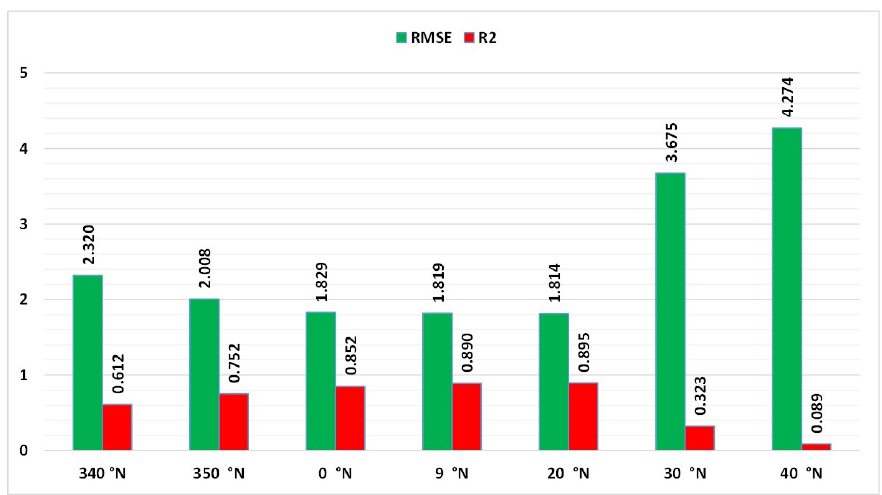
Figure 13. Best performance indices ( R 2 and RMSE ) for the seven equivalent directions analyzed within the LDR-equivalent direction significance study. Values were obtained by comparing the “measured” and “predicted” LRR functions.